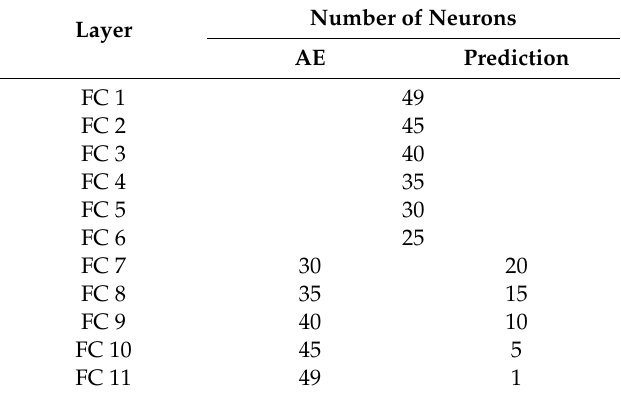
Table 1. Architectures of the designed AE-P network. After each layer except for the last one we used the ‘elu’ activation function, and after the last layer, we used the ‘tanh’ activation function. Number of Neurons Layer AE Prediction FC 1 49 FC 2 45 FC 3